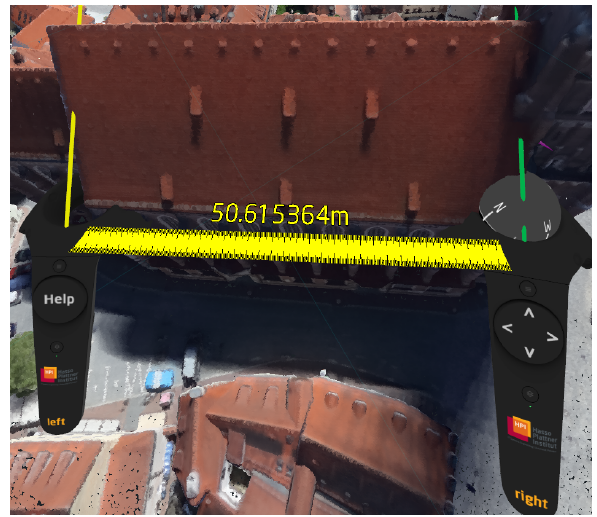
Figure 1. The virtual tape measure enables the user to take quick measurements in object